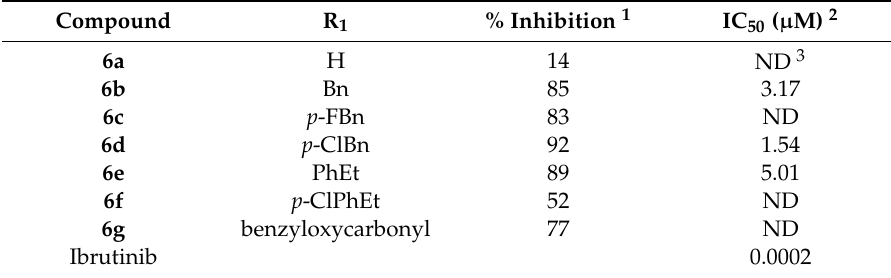
Table 1. Structure–activity relationship of piperazine-linked aminopyridine 6.